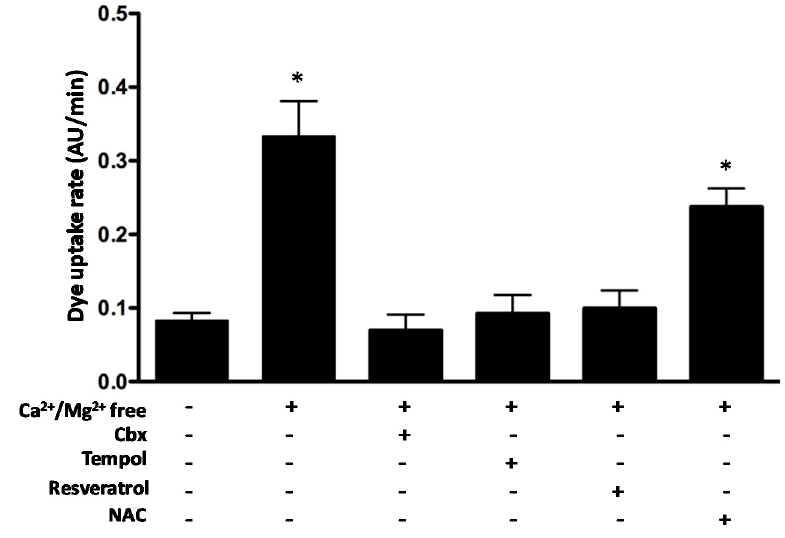
Figure 7. The antioxidant Tempol and Resveratrol blocks the Cx43 hemichannels in HeLa transfected cells bathed in divalent cation free solution. The activity of Cx43 HCs was measured using the dye uptake assays. Etd + uptake rate of HeLa Cx43 cells measured under control conditions (first bar) and after exposure to (Ca 2 + / Mg 2 + free) Krebs solution. Notice the enhanced dye uptake after incubation in Ca 2 + / Mg 2 + -free solution that induces opening of Cx HCs was prevented by carbenoxolone (Cbx; 100 µ M) a Cx HC blocker. The cells were then treated with Tempol (500 µ M), Resveratrol (200 µ M) or N-acetylcysteine, NAC (5 mM). * p < 0.05 significantly di ff erent from basal conditions. n = 4.